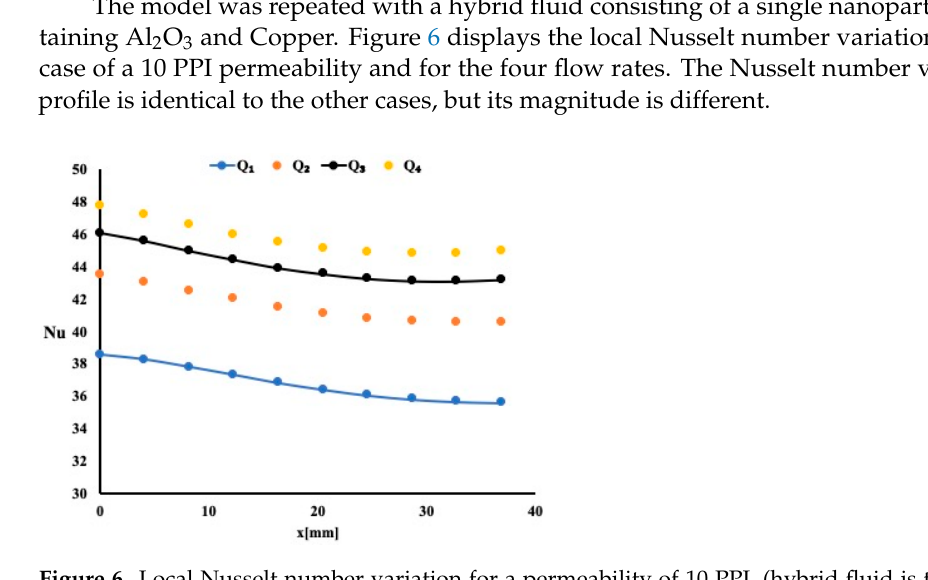
Figure 6. Local Nusselt number variation for a permeability of 10 PPI. (hybrid fluid is the working fluid). ing